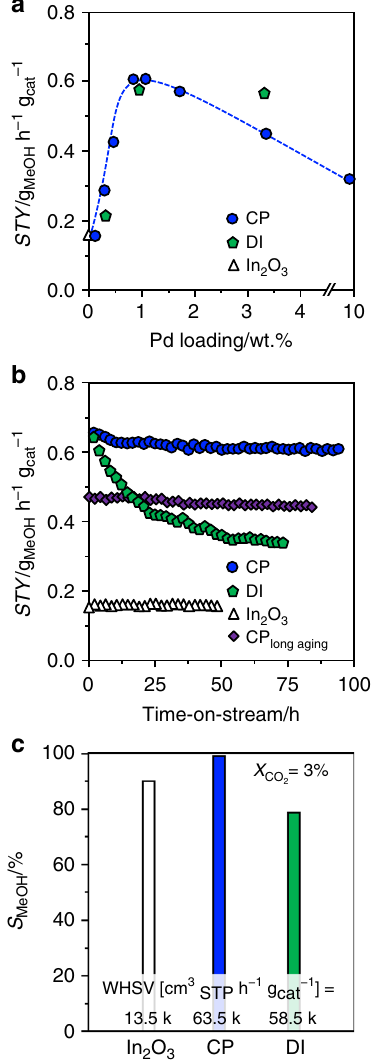
Fig. 1 Catalytic performance of palladium-promoted In 2 O 3 catalysts. a Impact of Pd loading on methanol space – time yield ( STY ) after 1 h on stream for palladium-promoted In 2 O 3 catalysts obtained by co-precipitation (CP) and dry impregnation (DI), b temporal evolution of the methanol STY for CP and DI catalysts, with pure In 2 O 3 as a reference, and c methanol selectivity over the same materials after 48 h on stream, when a CO 2 conversion of 3% is attained by operation at the indicated WHSV . In b , data of an additional CP catalyst is presented that was aged for 200 instead of 1 h. Reaction conditions: T = 553 K, P = 5 MPa, H 2 :CO 2 = 4, and WHSV = 24,000 cm 3 STP h − 1 g cat − 1 unless otherwise